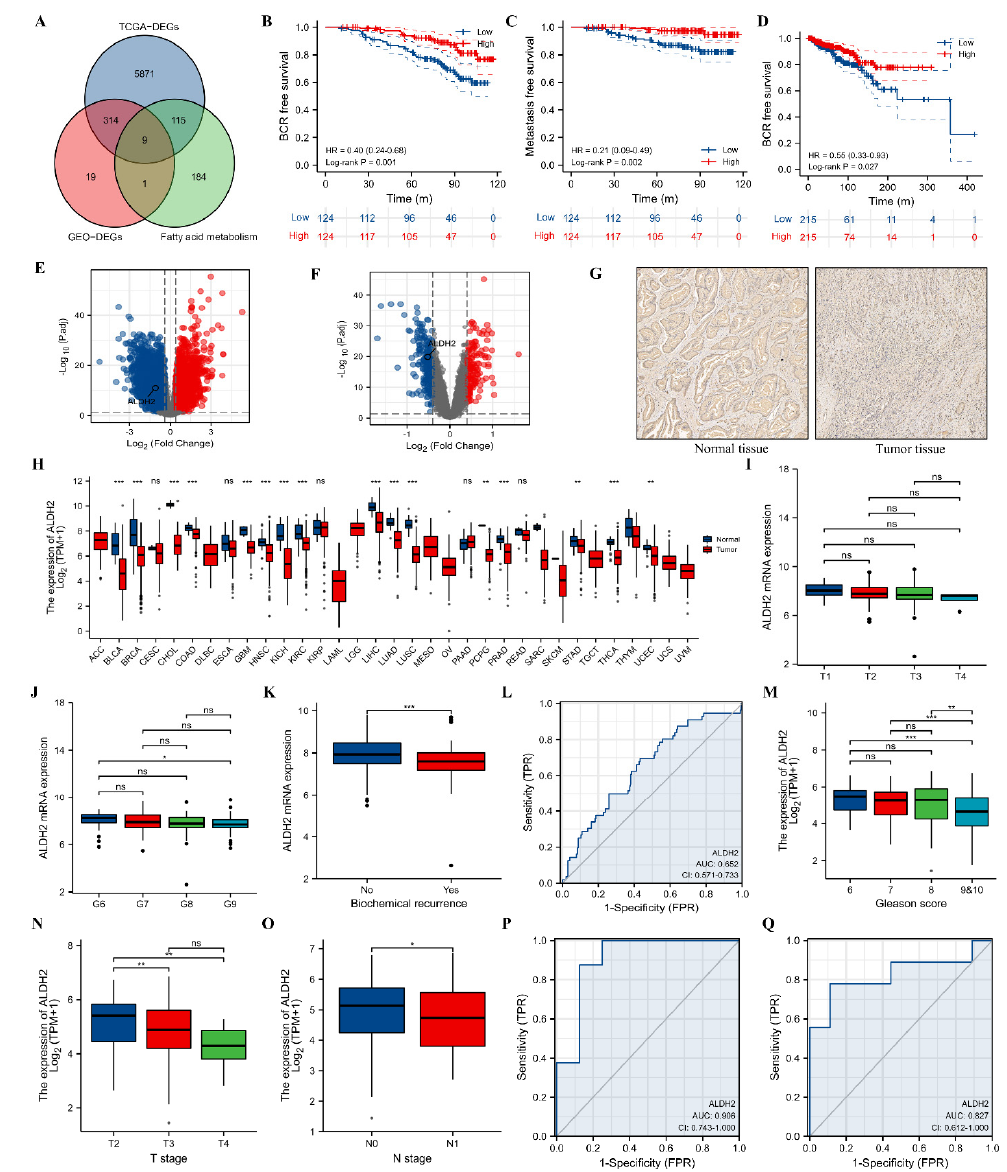
Figure 1. The clinical values of ALDH2 in prostate cancer. ( A ) Venn plot showing through the intersection of DEGs of TCGA database and GEO datasets, and gene sets of fatty acid metabolism; ( B ) Kaplan–Meier curve of ALDH2 for BCR-free survival; ( C ) Kaplan–Meier curve of ALDH2 for metastasis-free survival; ( D ) Kaplan–Meier curve of ALDH2 for BCR-free survival in TCGA database; ( E ) volcano plot showing DEGs in TCGA database; ( F ) volcano plot showing DEGs in GEO datasets; ( G ) differential expression of ALDH2 between tumor and normal tissues at protein level; ( H ) differ- ential mRNA expression of ALDH2 between tumor and normal sample at pan-cancer level in TCGA database; ( I ) comparison between ALDH2 and T stages; ( J ) comparison between ALDH2 and Gleason score; ( K ) comparison between ALDH2 and BCR; ( L ) ROC curve of ALDH2 discriminating BCR from no BCR; ( M ) comparison between ALDH2 and Gleason score in TCGA database; ( N ) comparison between ALDH2 and T stages in TCGA database; ( O ) comparison between ALDH2 and N stages in TCGA database; ( P ) ROC curve of discriminating drug resistance from drug sensitivity; and ( Q ) ROC curve of discriminating radiation resistance from radiation sensitivity. DEG = differentially expressed genes; BCR = biochemical recurrence; ROC= receiver operating characteristic curve. ns, 0.05; *, 0.05; **, 0.01, and ***,